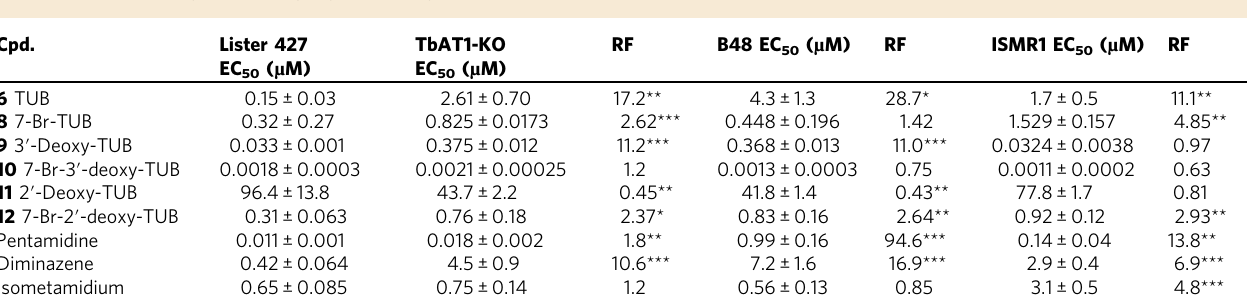
Table 2 In vitro drug sensitivity against drug-resistant T. brucei .